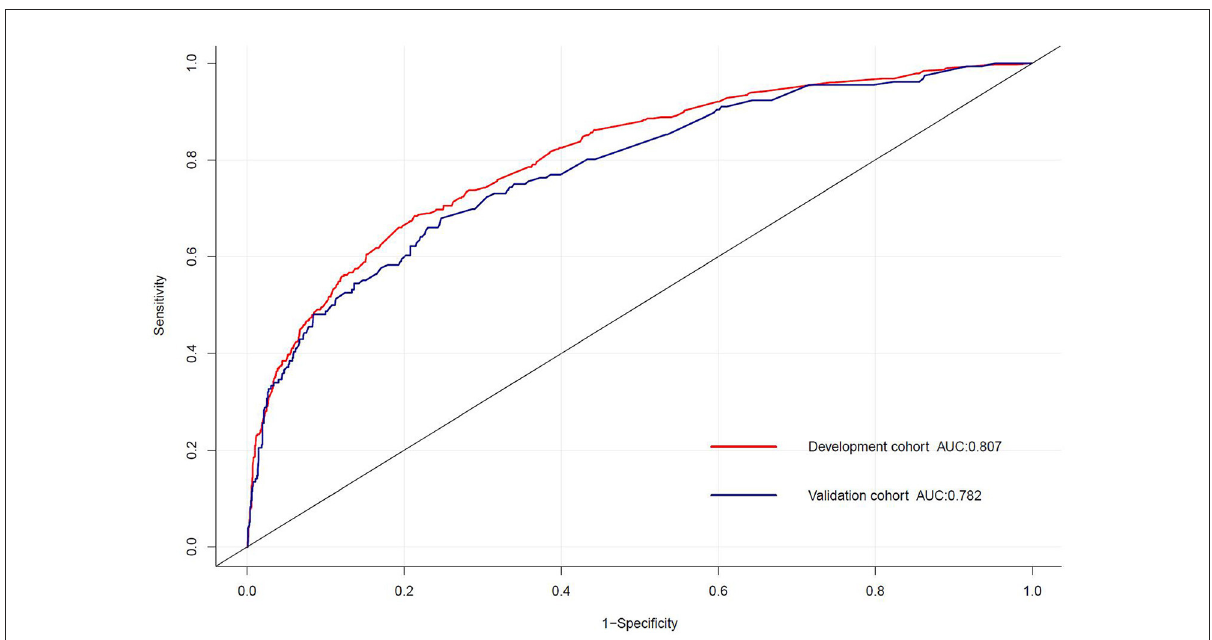
FIGURE3 The receiver operating characteristic (ROC) curve for the prediction model of delayed extubation. The area under the curve (AUC) of the model exhibited good discriminating power in the development and validation